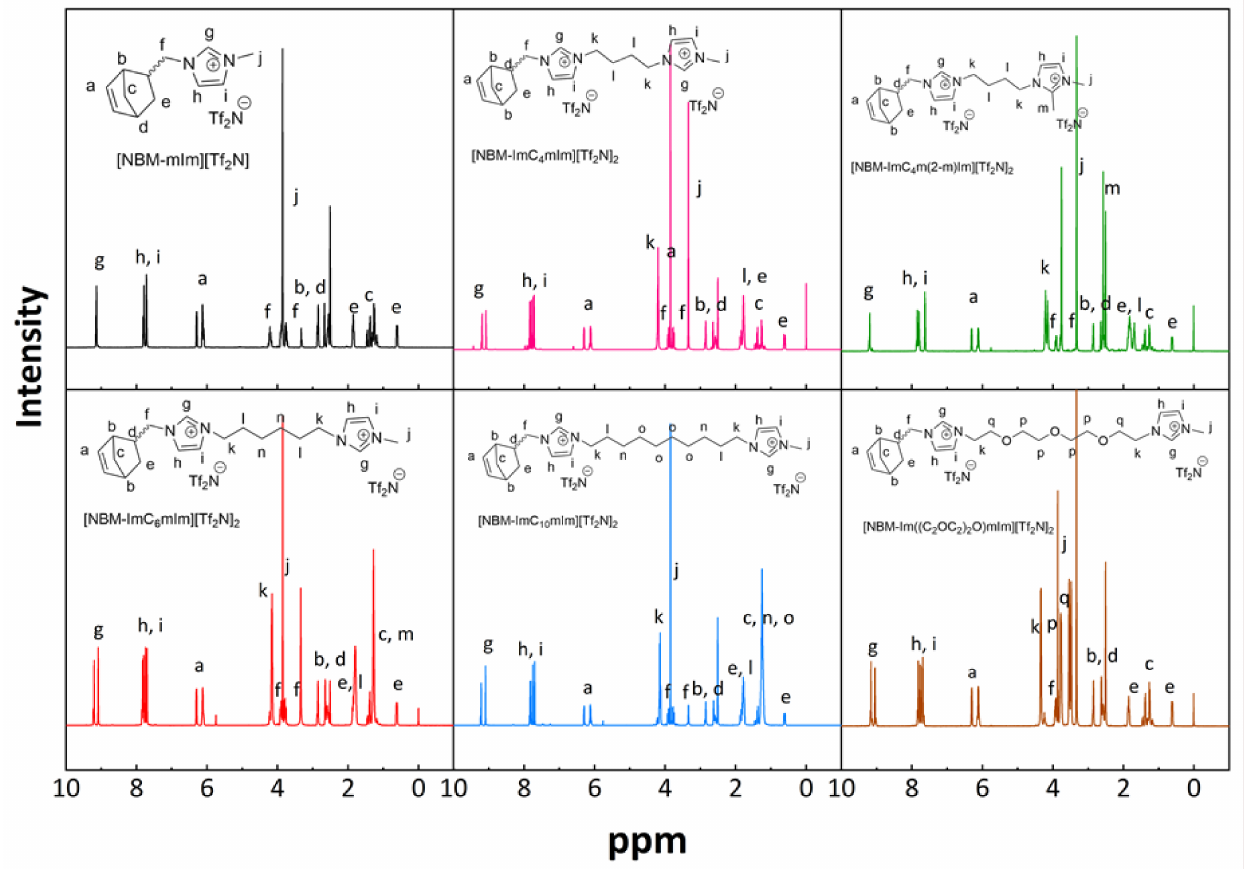
Figure 1. 1 H NMR spectra of [NBM-mIm][Tf 2 N] and [NBM-DILs][Tf 2 N] 2 in dmso- d 6